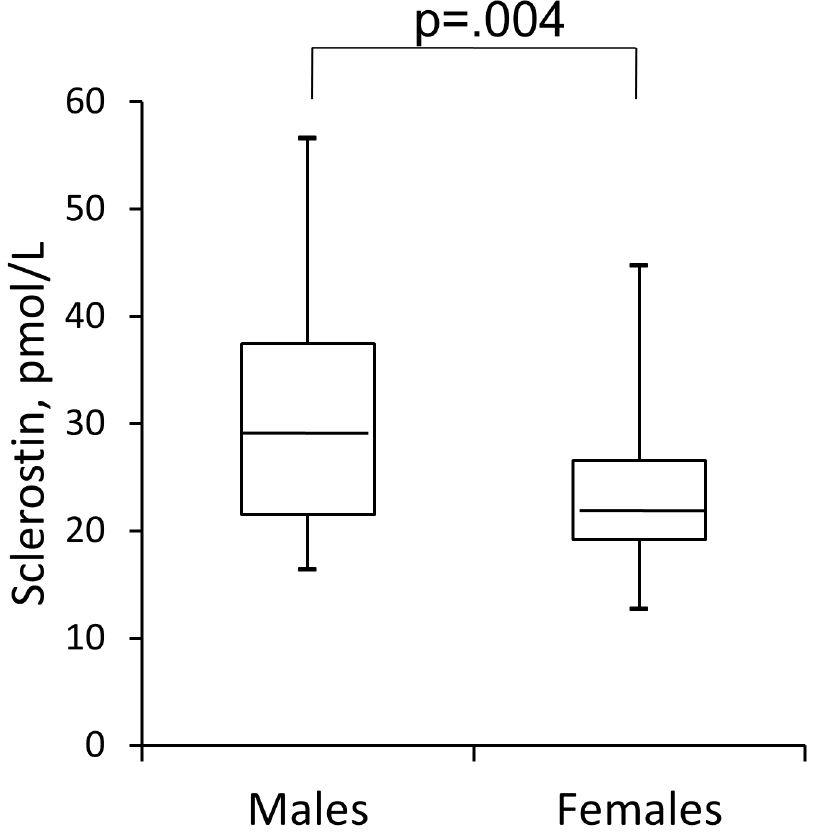
Fig 1. Gender differences in Sclerostin serum levels in renal transplantation. Indicatedare medians, first and third quartiles, minimaland maximal values. Males versus Females p < .05.